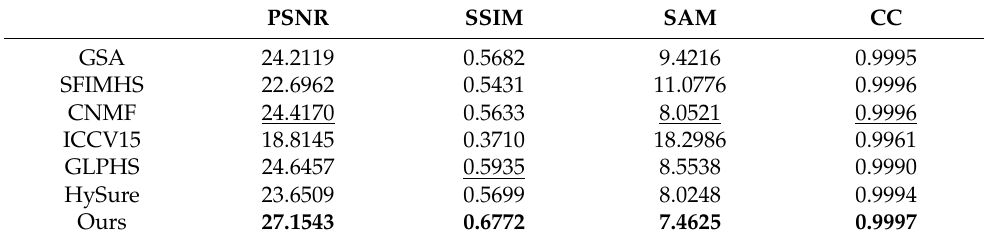
Figure 11. Residual information of Houston 2018 dataset with real multispectral images. ( a ) results of GSA; ( b ) results of SFIMHS; ( c ) results of GLPHS; ( d ) results of CNMF; ( e ) results of ICCV15; ( f ) results of HySure; ( g ) ours results. Table 5. Quantitative evaluation results of Houston 2018 dataset with real multispectral images. PSNR SSIM